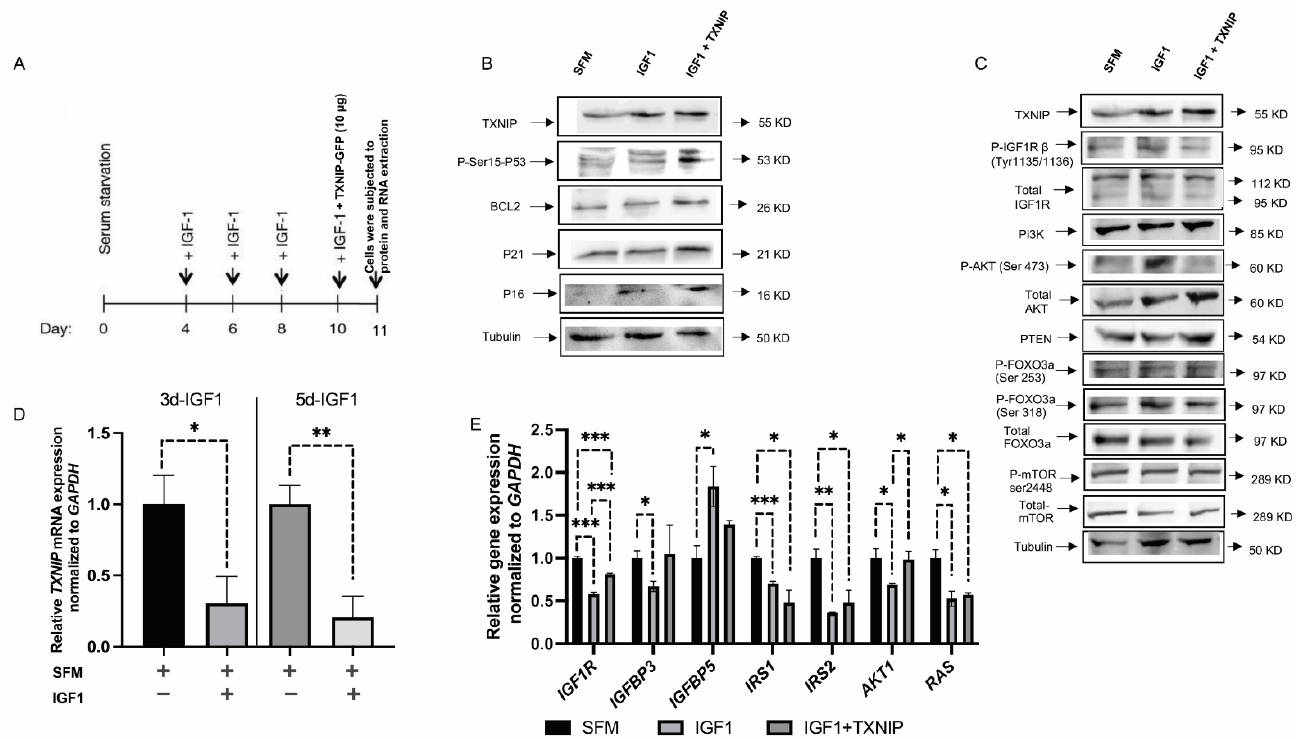
Figure 4. Effect of TXNIP on prolonged IGF1-induced senescence . ( A ) Schematic representation of senescence induction by prolonged IGF1 treatment. ( B , C ) Primary skin fibroblasts were treated with IGF1 for 11 days, transfected with a TXNIP-GFP vector during the last 24 h of IGF1 treatment, or serum-starved for the entire period and transfected with an empty pcDNA-GFP plasmid (SFM). At the end of the incubation period, cells were harvested and the indicated proteins were measured by Western blots. ( D ) Relative TXNIP mRNA levels upon 3 or 5 days of IGF1 treatment with IGF1 (or serum starved controls). ( E ) Gene expression analysis in IGF1-induced premature senescence with or without TXNIP-GFP transfection. GAPDH mRNA levels served as an internal control. * p -value ≤ 0.05; ** p - value ≤ 0.01; *** p - value ≤ 0.001.